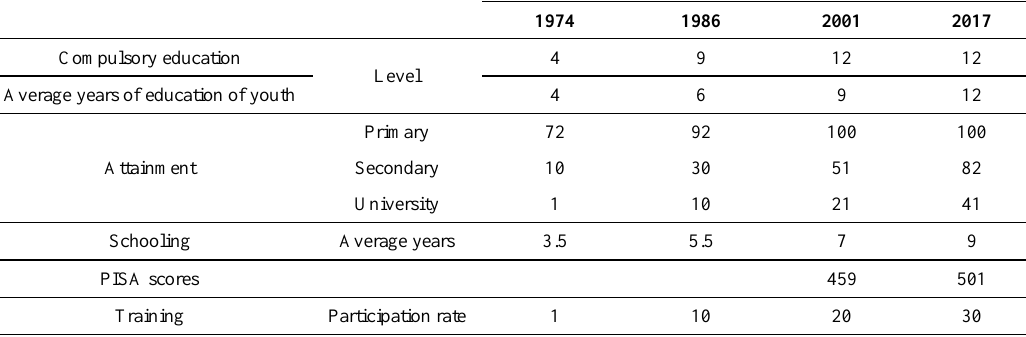
Table 3. Basic data of broad education and training systems